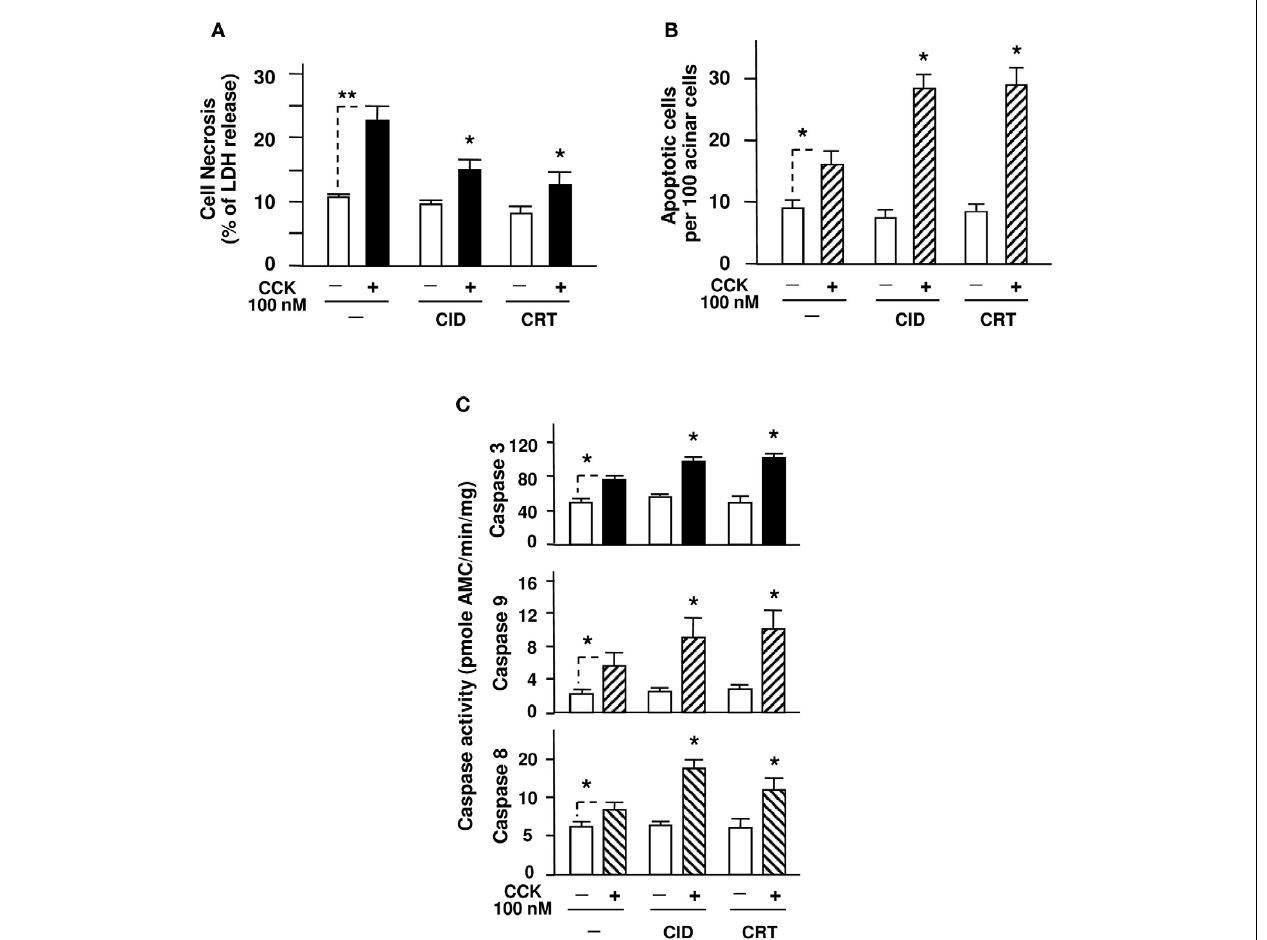
FIGURE 2 | PKD inhibitors CID755673 and CRT0066101 decrease necrosis and enhance apoptosis in pancreatic acini induced by supramaximal dose CCK. Rat pancreatic acini were pre-incubated for 1h with CID755673 (CID, 25 μ M) or CRT0066101 (CRT, 10 μ M), followed by incubation with 100nM CCK for 4h. (A) Acinar cell necrosis was measured by the percentage of total cellular LDH released into the medium, as described in